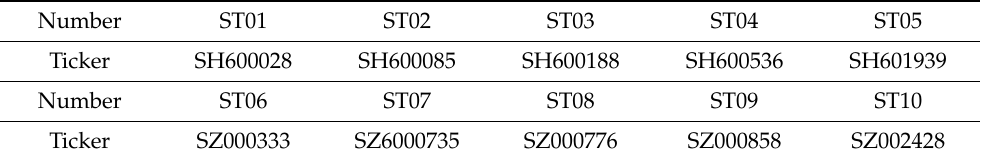
Table 1. Sample assets.